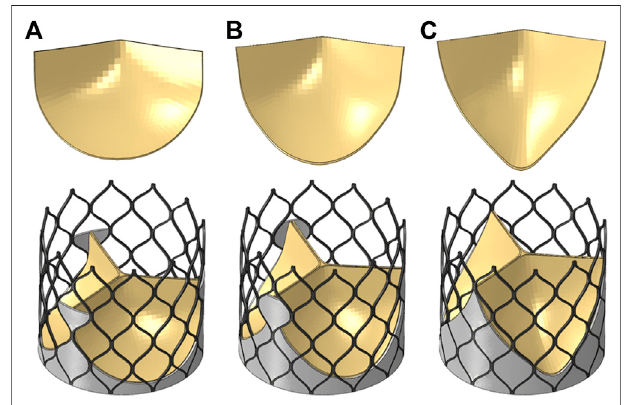
FIGURE 3 | Three valve lea fl et models and three valve stent models, (A) model A, (B) model B, (C) model C.